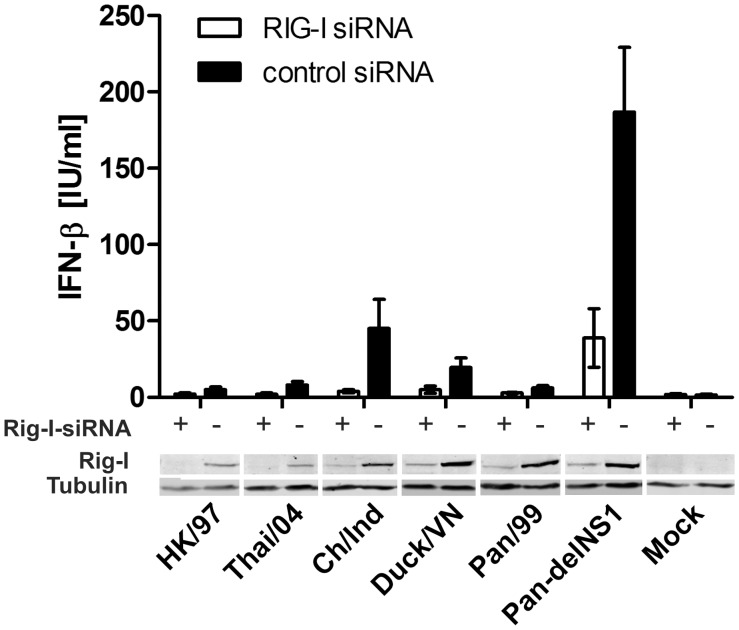
IFN-α/β secretion in response to H5N1 infection depends on RIG-I expression.A549 cells, transfected with either RIG-I-specific (+, open columns) or control (–, solid columns) siRNA were infected with the indicated H5N1 and the Pan/99 (H3N2) derived viruses (MOI = 1). IFN-β concentrations were determined via ELISA (Fujirebio, Japan) in cell culture supernatants taken 16 h post infection (upper panel) and RIG-I expression was determined by immunoblotting (lower panel). Mean data +/– SEM of four independent experiments and a representative immunoblot is shown.